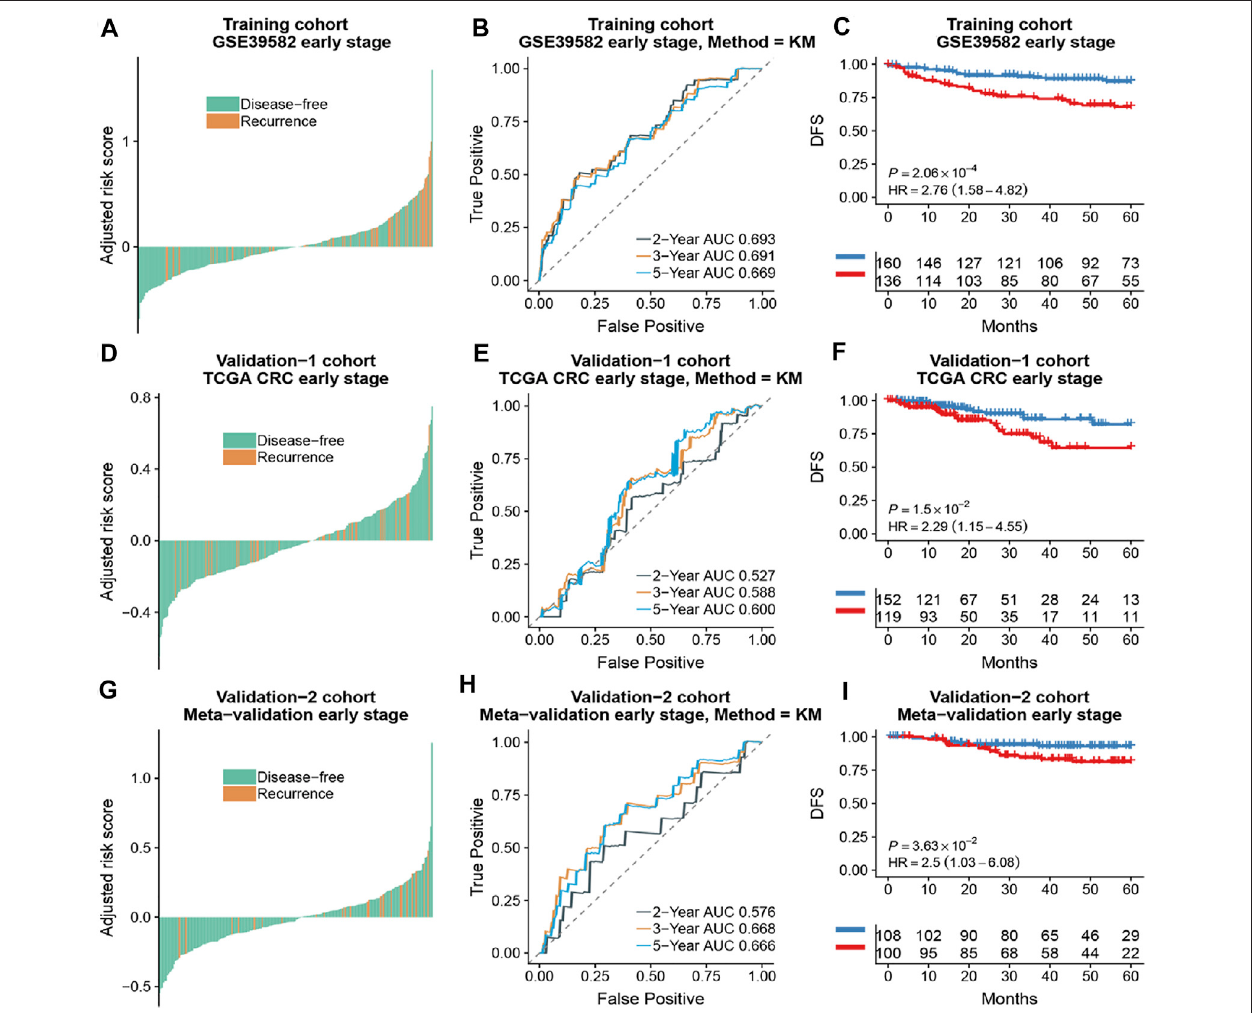
FIGURE 4 | The association of the ATG signature with DFS in early-stage (stage I and II) patients with CRC. Patients with CRC of the early stage were ranked by autophagyriskscoresinthetrainingcohort (A) ,theTCGAcohort (D) ,andthemeta-validationcohort (G) .Time-dependentROCcurvesforDFSinearlystage(stageIand II) patients achieved with different durations in the training cohort (B) , the TCGA cohort (E) , and the meta-validation cohort (H) . Kaplan – Meier curves showed DFS of early-stage patients in low and high autophagy groups in the training cohort (C) , the TCGA cohort (F) , and meta-validation cohort (I) , respectively. p values comparing risk groups were calculated with the log-rank test. Hazard ratios (HRs) and 95% CIs are for low vs. high autophagy risk. CRC, colorectal cancer; ATG, autophagy-related gene; DFS, disease-free